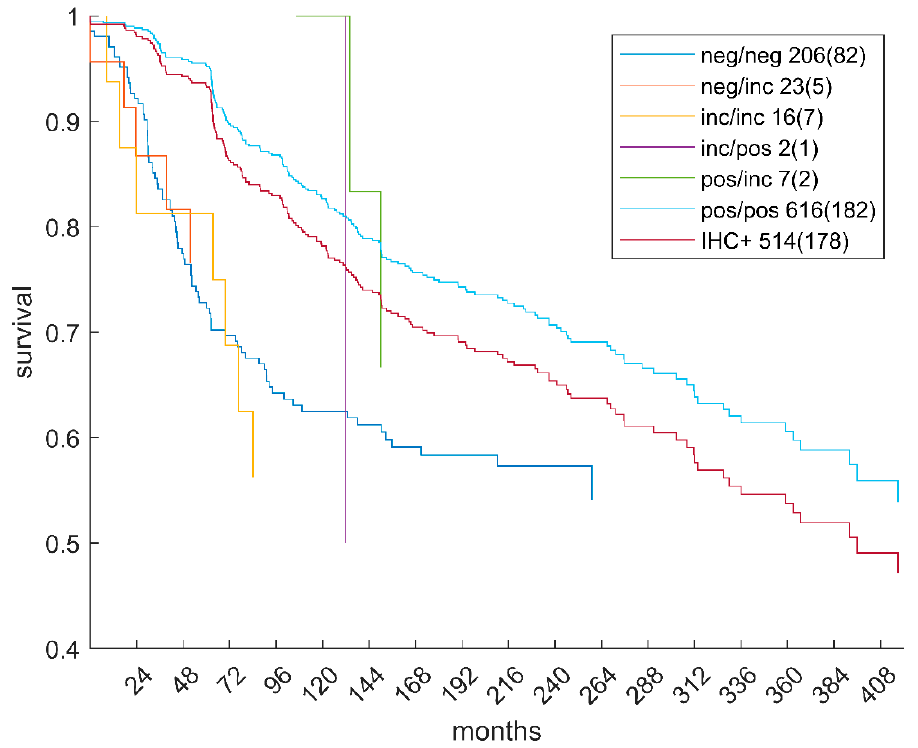
Figure 7. Survival free from recurrence. Kaplan–Meier estimates were obtained for several patient subgroups in Table 1. Legend acronyms refer to cells in Table 1 as ODDS/DST, figures give numbers of patients with survival data available and number of events (i.e., recurrences) in parenthesis. The curve ‘IHC+’ refers to patients diagnosed receptor positive according to current clinical standards, i.e., positive for estrogen or progesterone (or both).